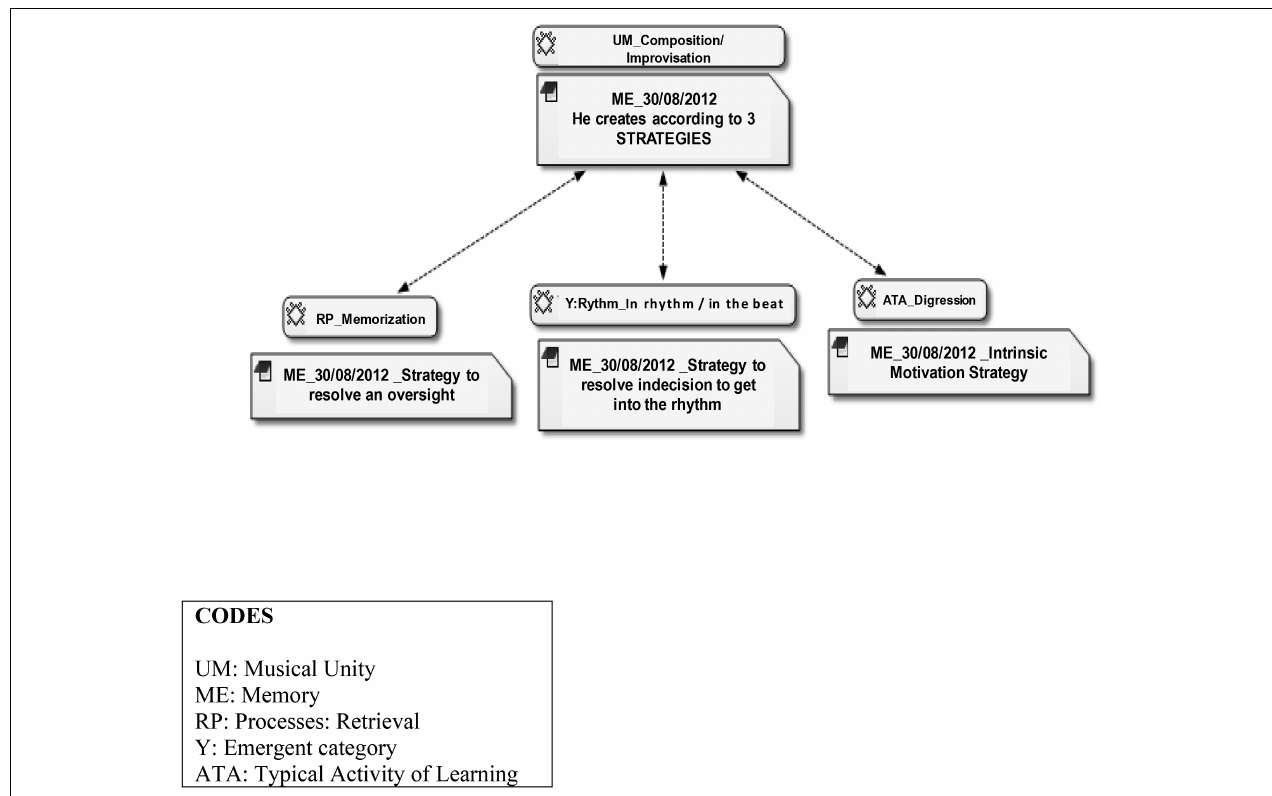
FIGURE 4 | Sequence function where apprentice with Transformative approach establishes three strategies of musical creation.